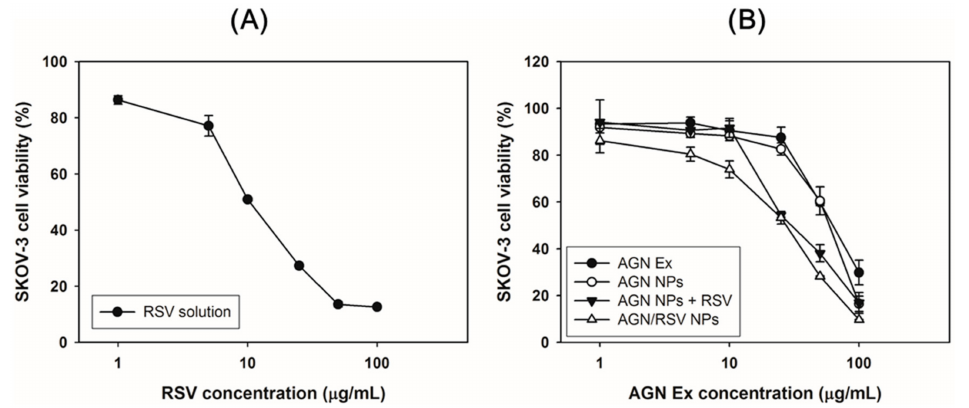
Figure 6. The antiproliferation data of RSV, AGN Ex, AGN NPs, AGN NPs + RSV, and AGN/RSV NPs in SKOV-3 cells. The cell viabilities according to RSV concentration ( A ) and AGN Ex concentration ( B ) are presented. The data are presented as the mean ± SD ( n =